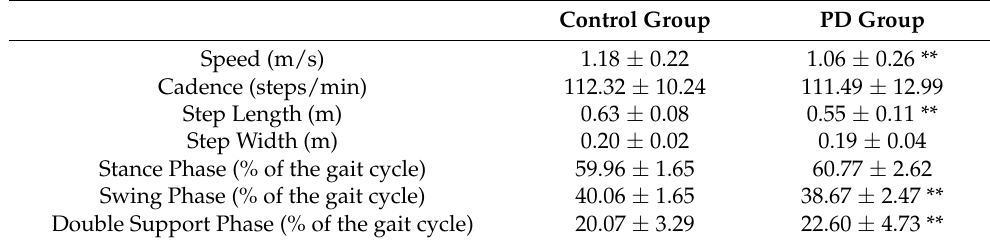
Table 2. Spatiotemporal parameters of gait. Stance, swing and double support phases are expressed as percentage of the gait cycle duration. Values are expressed as mean ±